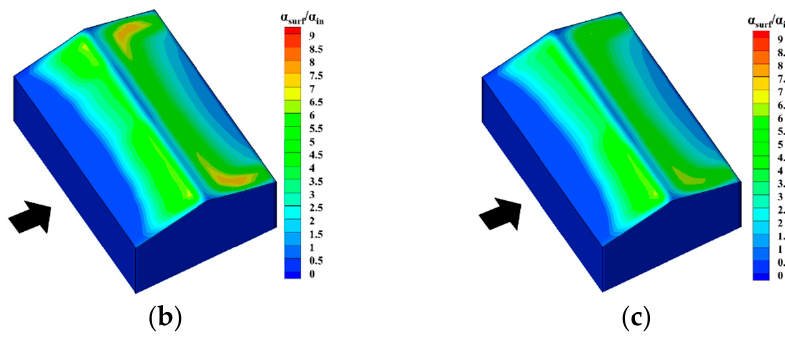
Figure 20. Normalized volume fraction of drifting snow α surf / α in on the gable roof: ( a ) volume fraction: 7.8 × 10 − 6 ; ( b ) volume fraction: 1.56 × 10 − 5 ; ( c ) volume fraction: 2.34 × 10 − 5 .